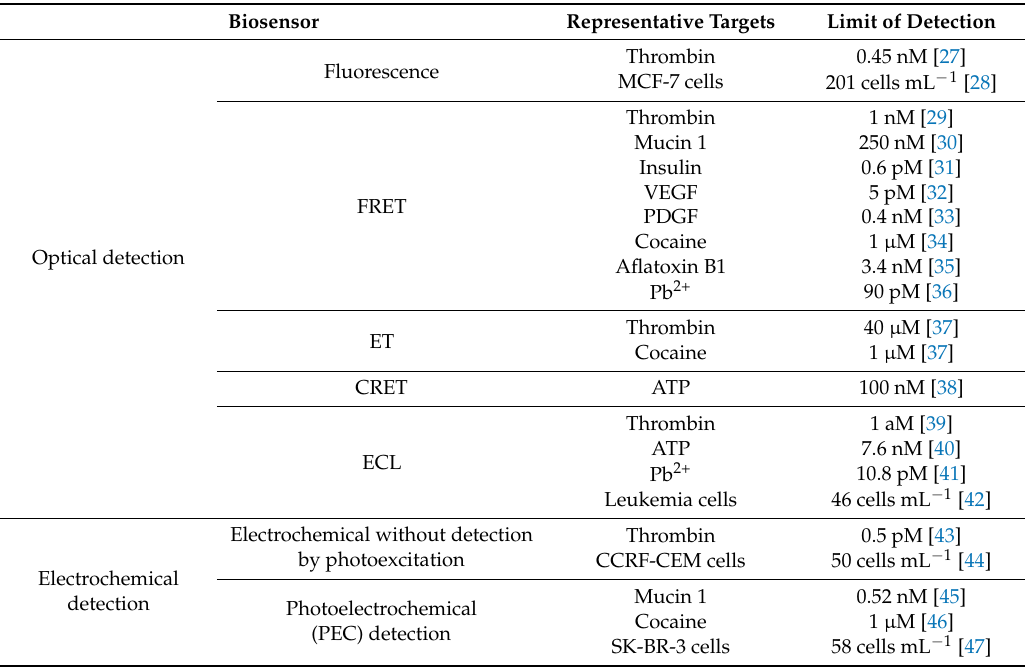
Table 1. A brief overview of QD-aptamer